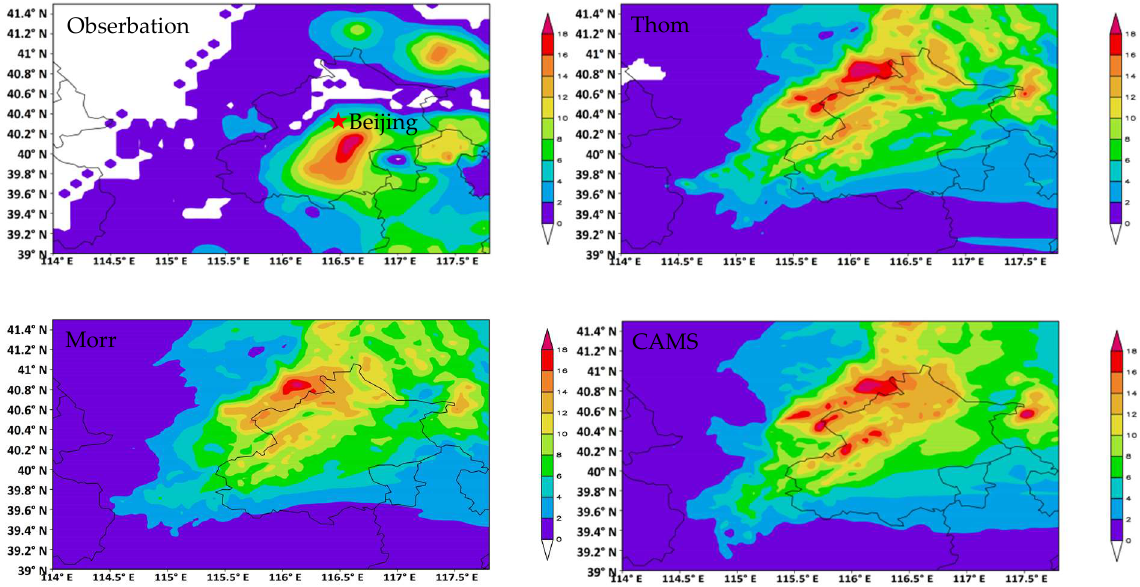
Figure 1. Daily snowfall distributions of observation and simulation results of the three explicit schemes (mm); ★ indicates the location of Beijing.